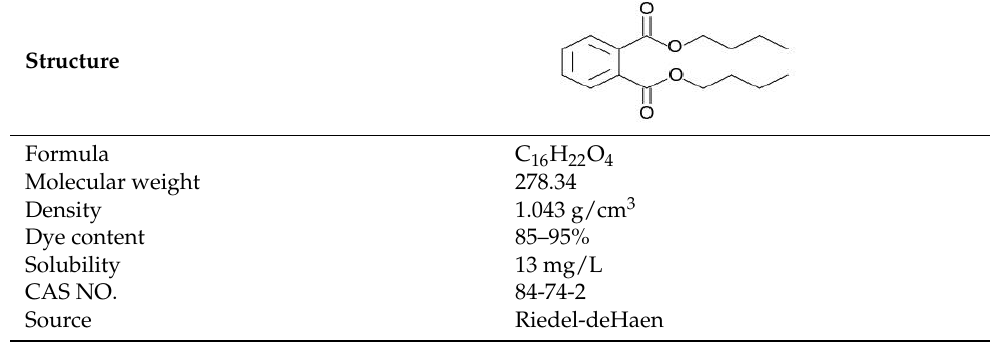
Table 3. Basic characteristics of DBP.